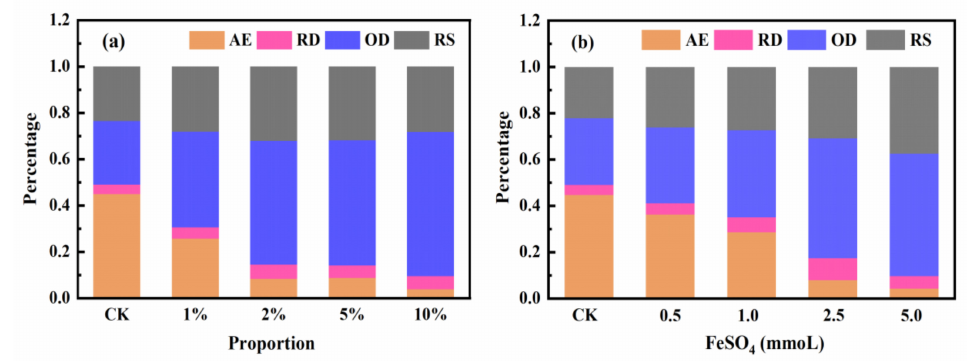
Figure 5. Proportion of Cr in each fraction of the soil samples before and after remediation with ( a ) 0.5 CMC@MMT-FeS; and ( b ) FeSO 4 reagent. Fractions were measured using the modified BCR (European Community Bureau of Reference) method (AE, acid-exchangeable fraction; RD, reducible fraction; OD, oxidable fraction; RS, residual fraction). CK: control